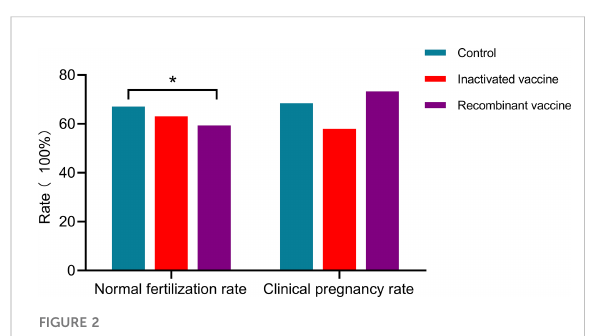
FIGURE 2 Preganncy outcomes in different vaccine type. *